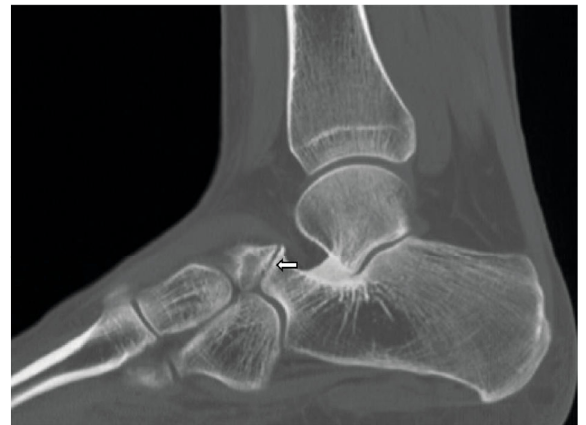
Figure 4: Sagittal hindfoot in a 20-year-old female demonstrating a nonosseous calcaneonavicular coalition. Note the irregular, opposing joint